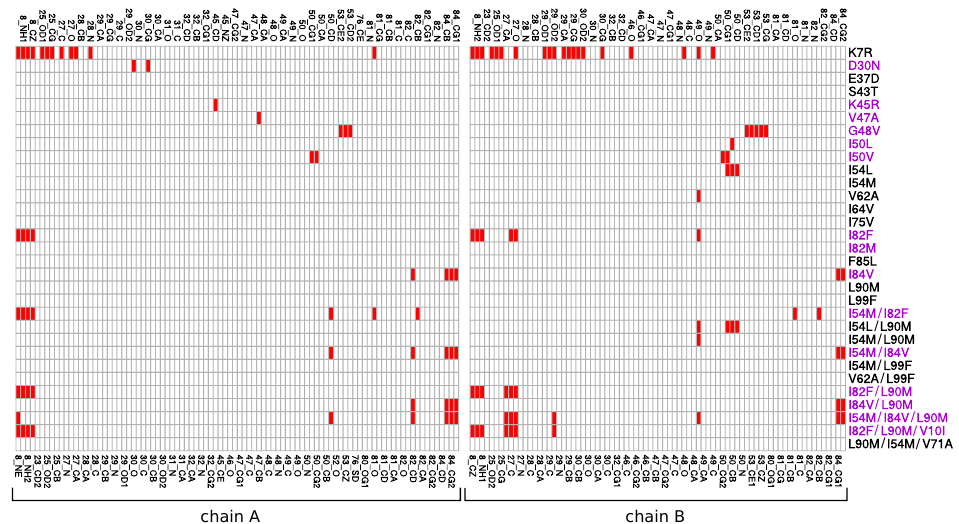
Figure A4. MCS atoms in the pocket. Mutants colored in purple present at least a mutation located in the binding pocket.